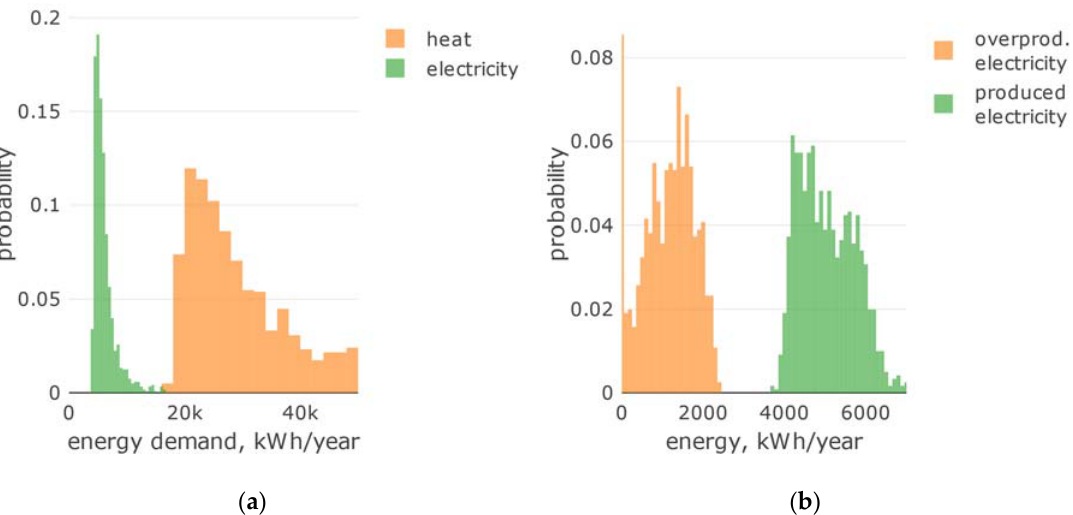
Figure 17. ( a ) Energy demand histogram for heat and electricity for chosen group; ( b ) Produced and overproduced electricity histogram for chosen group. Selected group—Figure 16b for EPI=1.0 and GPI=1.0.